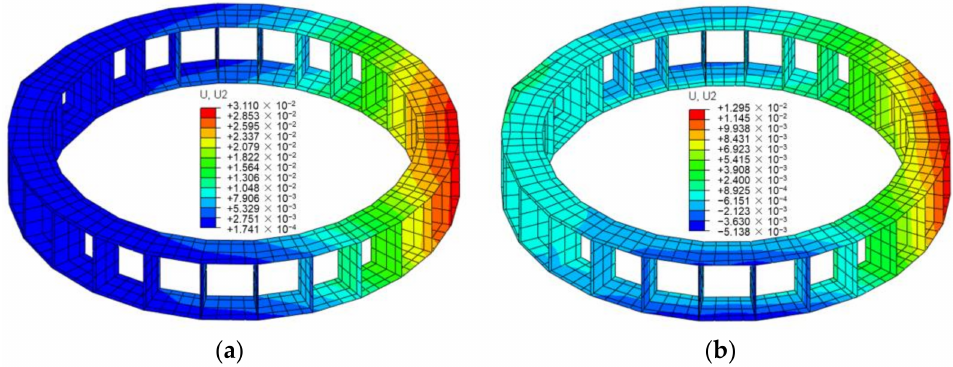
Figure 12. Vertical displacement of the stay ring (m): ( a ) unwatered case; ( b ) pressurized